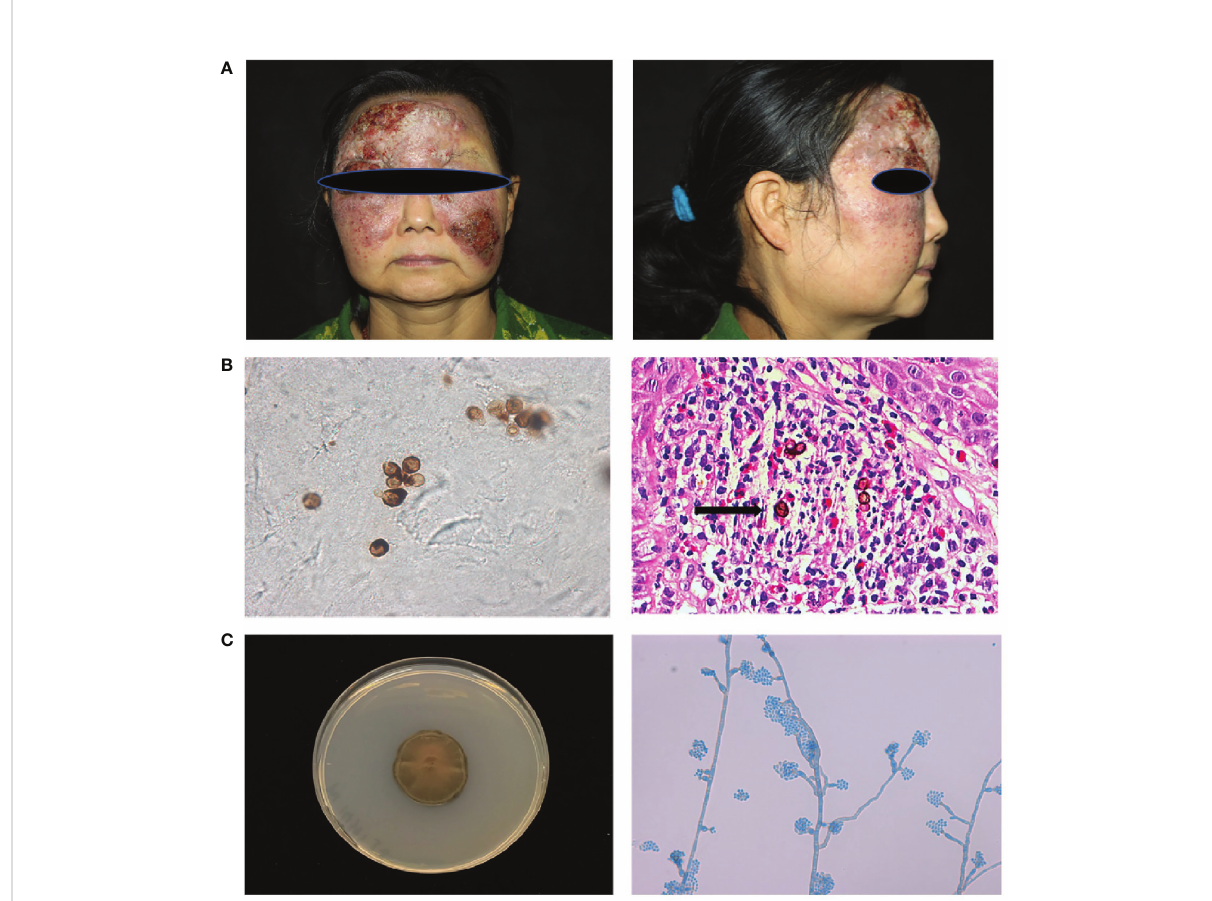
FIGURE 1 Clinical features, laboratory fi ndings of patient 1. (A) A protuberant dark red mass on the face with erosion, crust, and pus, which covered the forehead and cheek with a clear boundary. (B) Smear of the lesion scrapings showed brown sclerotic cells with cross septa. Histopathological examination of the skin lesion showed pseudoepitheliomatous hyperplasia of the epidermis, and intense dermal in fl ammatory in fi ltrations with the presence of sclerotic cells in the dermis (Haematoxylin and eosin stain; 400× original magni fi cation) (C) Macroscopic appearance of the cultured pathogen: the colony was brown to blackish ‐ green with abundant short, grey aerial hyphae (Potato dextrose agar, 14 d at 28°C). Microscopic examination of the cultured organisms revealed vase-shaped sporogenous cells with collar-like structure and fl ower-like arrangement of small